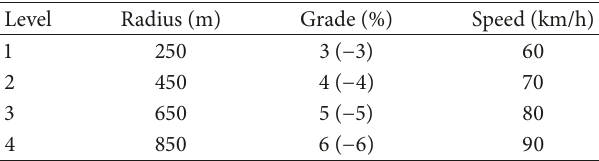
Table 3: Factors and corresponding